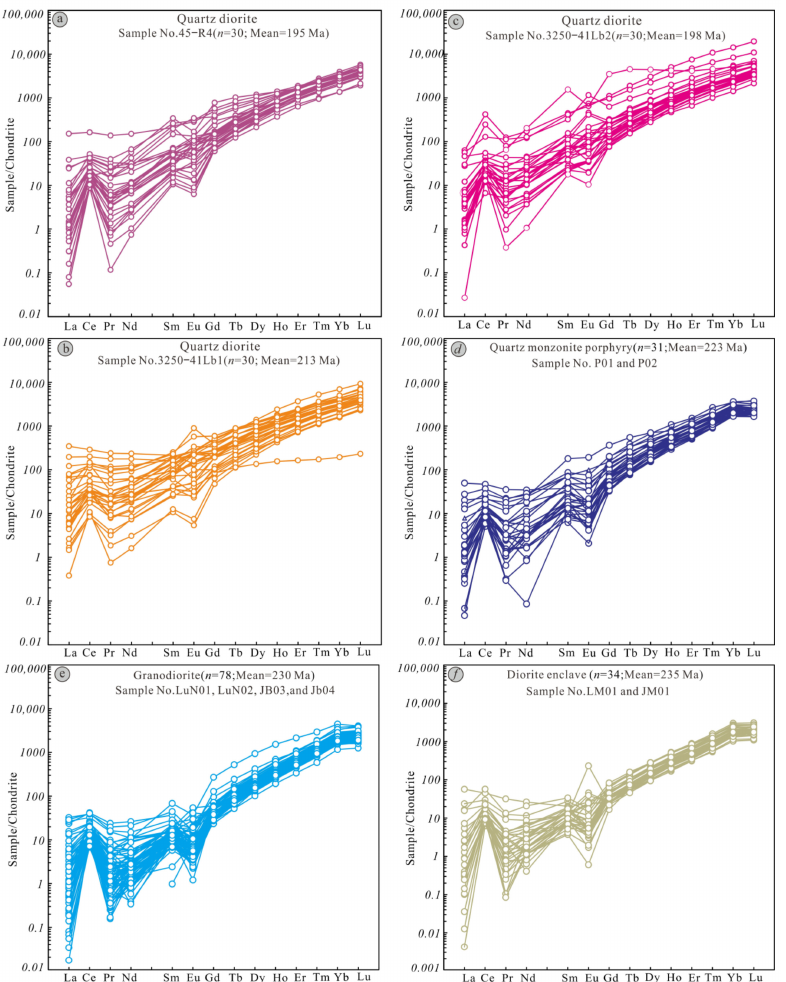
Figure 7. Plots of chondrite-normalized REE contents in zircons from Yangla granitoid plutons. The zircons data of granodiorite, diorite enclave, and quartz monzonite porphyry were sourced the Ref. [3]. Normalization values for chondrite after Ref. [53]. ( a – c ) chondrite-normalized REE patterns in zircon grains from Yangla quartz diorite; ( d ) chondrite-normalized REE patterns in zircon grains from Yangla quartz monzonite porphyry; ( e ) chondrite-normalized REE patterns in zircon grains from Yangla granodiorite; ( f ) chondrite-normalized REE patterns in zircon grains from Yangla diorite